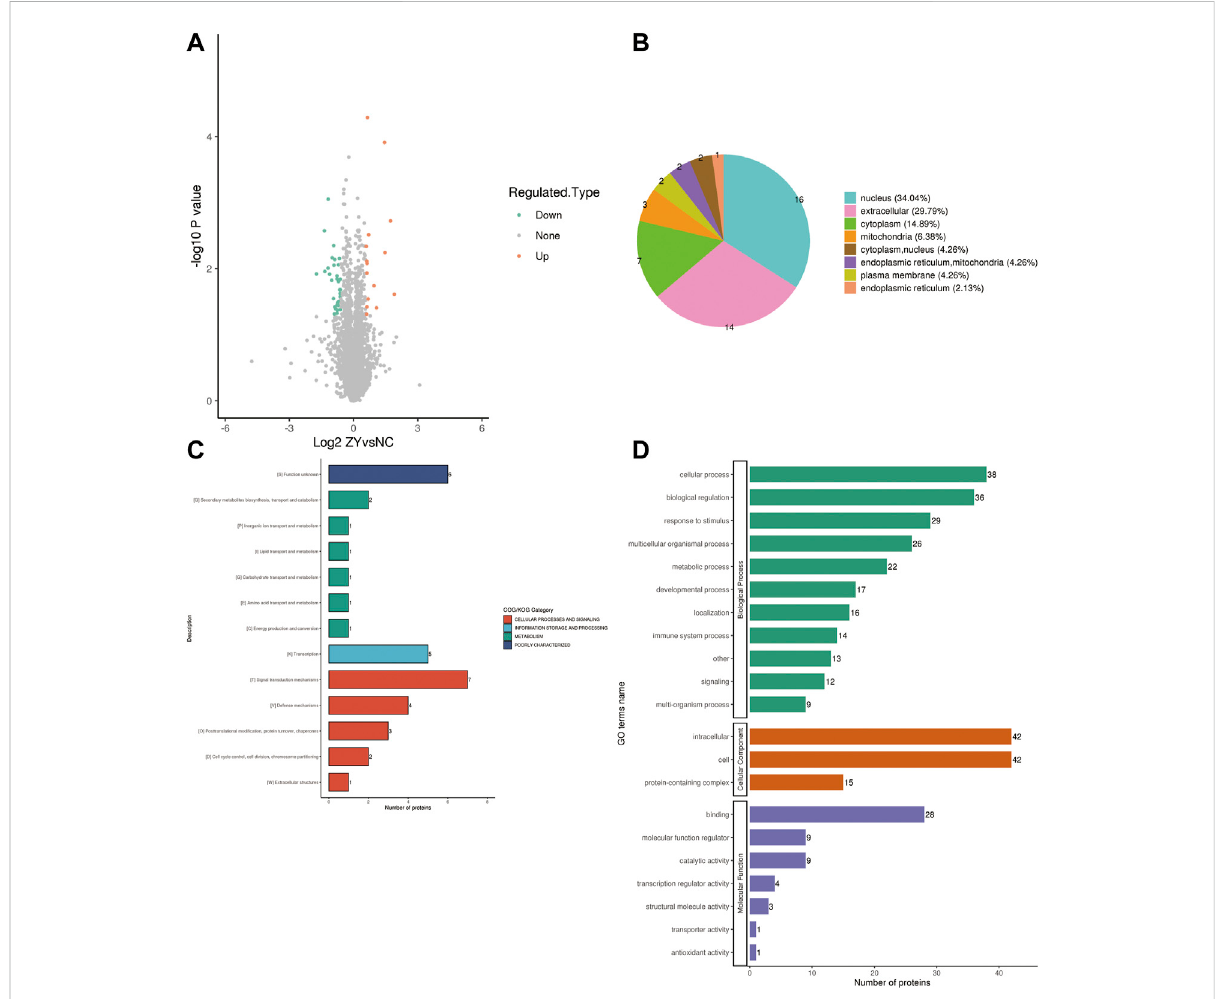
FIGURE 5 (A) AvolcanoplotdepictingtheDEPsbetweentheZYgroupandNCgroupwhenFC > 1.5. (B) SubcellularlocalizationofDEPsbetweenZYgroup vs. NC group. (C) COG/KOG analysis of DEPs between ZY group vs. NC group. (D) GO annotations of DEPs between ZY group vs. NC